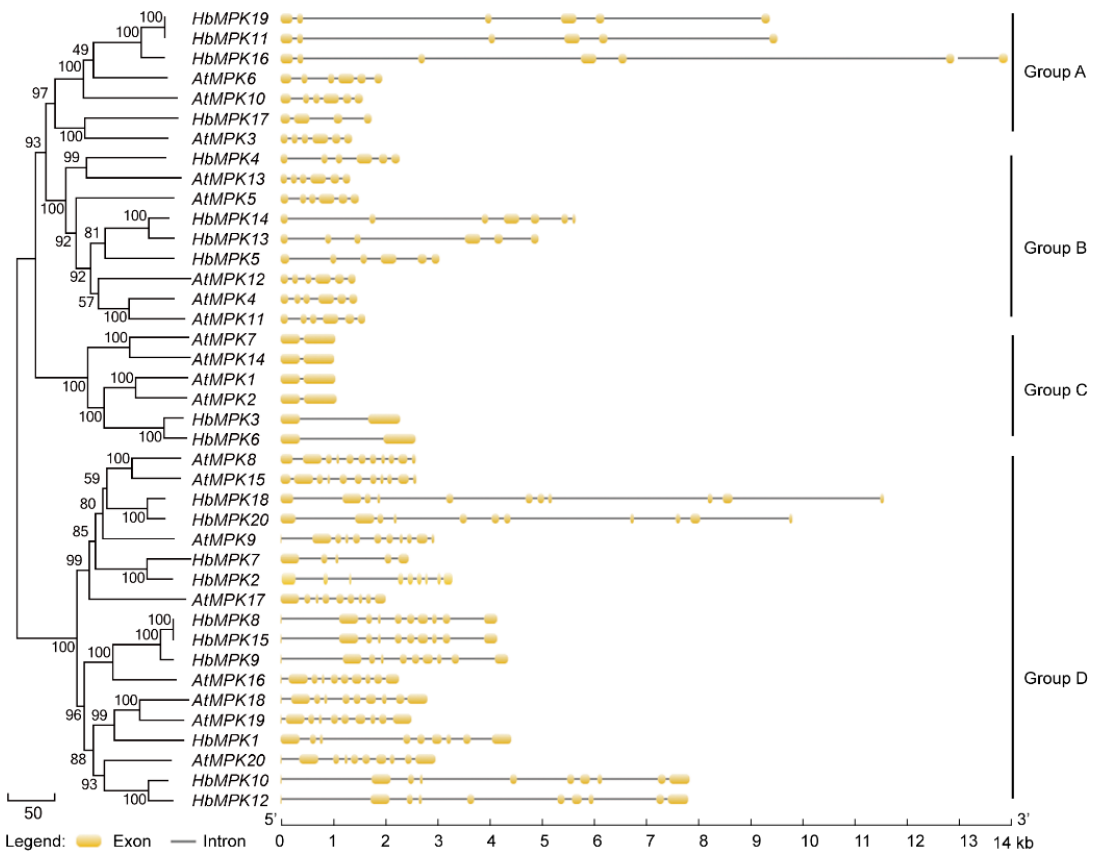
Figure 6. Phylogenetic and exon-intron structure analyses of MPK genes in Arabidopsis ( At ) and Hevea ( Hb ). The cladogram (left) was constructed using MEGA5.0 as described above. The exon-intron distribution (right) was analysed using GSDS software. Introns and exons are represented by lines and yellow boxes. The scale bar for genomic length is indicated at the bottom.